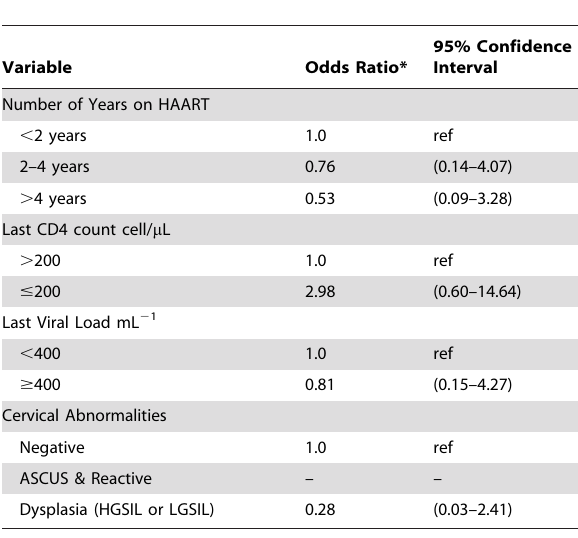
Table 3. Association between clinical factors and infections with HR 16 and/or 18 vs. other HR genotypes (n=